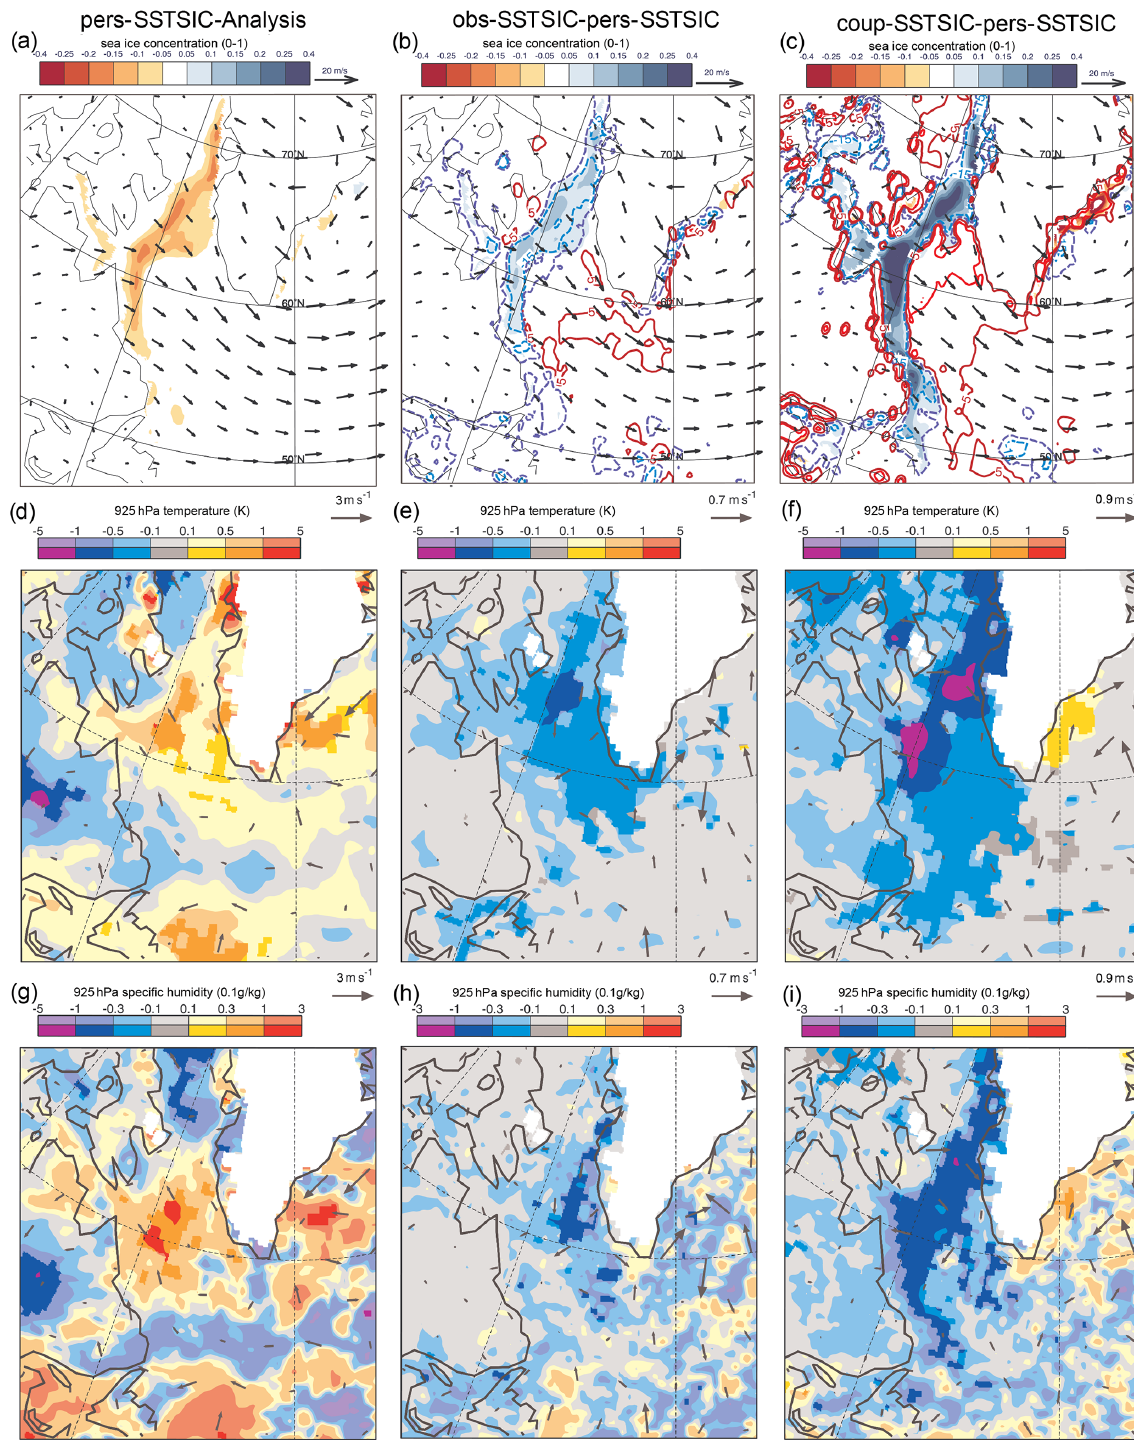
Figure 10. Composite of forecast error during periods of ice advance in the Labrador Sea and Baffin Bay: day-3 sea ice concentration bias along with composite-mean winds at 925hPa (a) , T + 72 925hPa temperature and horizontal wind bias (d) , and specific humidity and horizontal wind bias (g) for the pers-SSTSIC forecasts and the change in the bias for obs-SSTSIC ( b , e and h ) and coup-SSTSIC ( c , f and i ). The change in the turbulent heat flux (sensible + latent accumulated between T + 48 and T + 72) is shown in the blue and red contours in (b) and (c) (anomalies are positive downwards). In panels (d–i) , saturated colours indicate mean differences that are statistically significant at the 5%